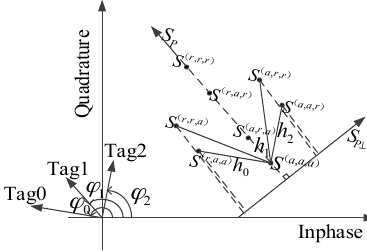
Figure 2. Mapping three collided tag signals to an IQ plane under a single receiving antenna.